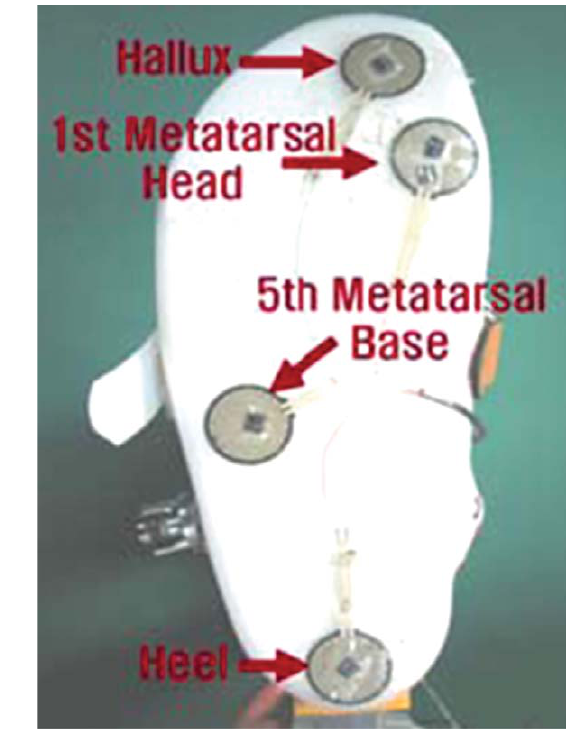
Fig. 3. The newly developed AAFO. Fig. 4. The placement of the FSR sensors. connected in a voltage divider circuit [12], since foot switches are simple and highly accurate sensors for detecting gait events. A total of four FSR sensors were used and were placed on the heel, the hallux, the first metatarsal head, and the fifth metatarsal base. The FSR sensors placed on the heel and the first metatarsal head were intended to detect gait events during normal gait.